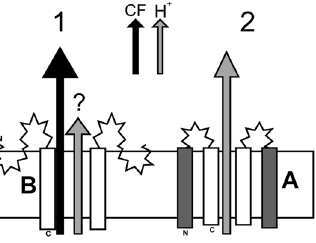
Figure 9. Schematic view of the proposed two forms of p7 (A and B). (1) In form B, TM2 is embedded in the lipid bilayer and the extra b -structure is contributed by exposure of TM1 to the aqueous environment. This form is able to release CF (black arrow), but not protons (grey arrow). As part of the B form extends into the extramembrane domain, it is likely to participate in fusion events or membrane destabilization; (2) Form A has two TM domains, TM1 and TM2, separated by a loop, where TM2 lines the lumen of the channel. This form is unable to release CF, but it is able to transport